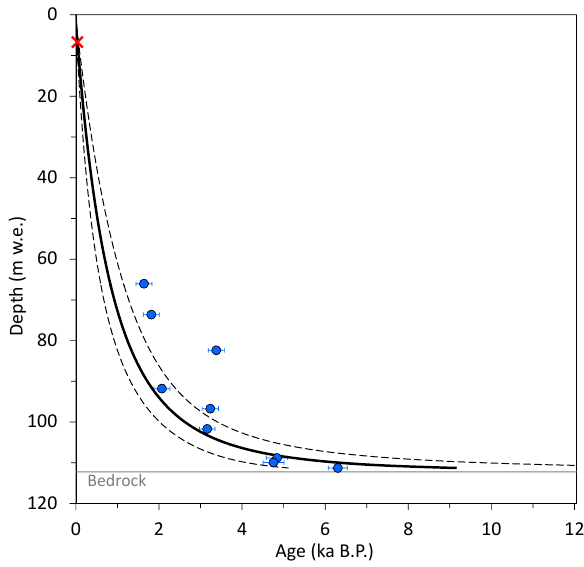
Figure 5. The depth–age relationship of the Chongce 135.8m Core 2. The dashed lines represent the 1 σ confidence interval of the 2p model fit (solid line). The red cross stands for the β activity horizon (Fig. 2) and the blue dots for the calibrated 14 C ages with 1 σ error bars.